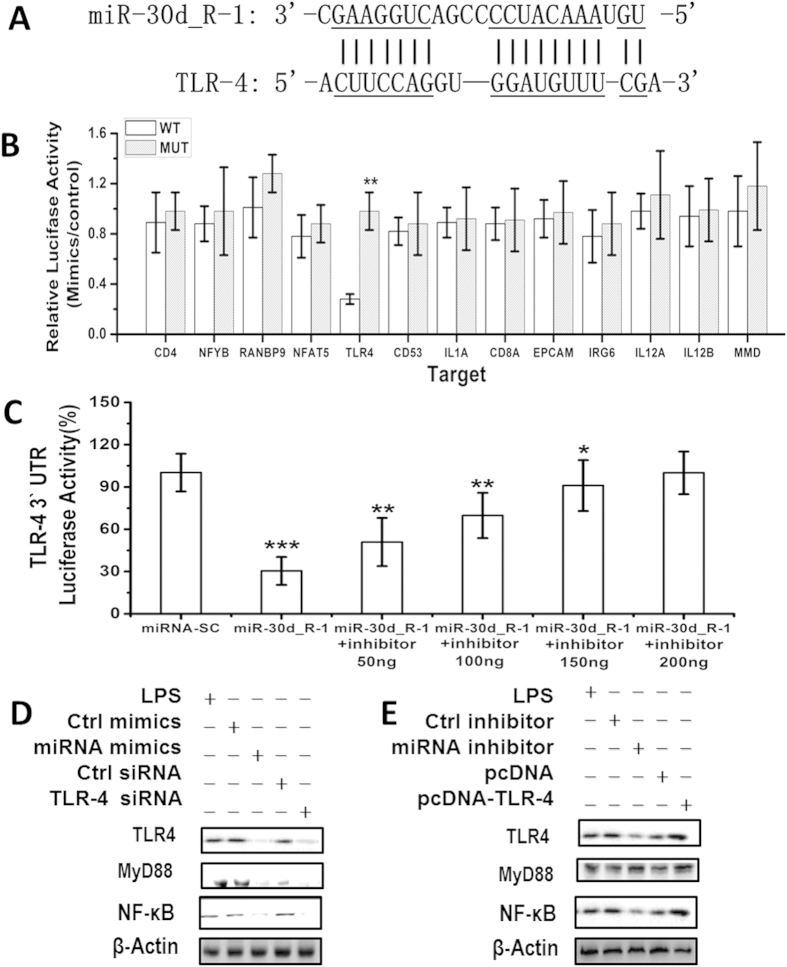
Direct targeting of TLR4 mRNA by ssc-miR-30d_R-1.The predicted conserved ssc-miR-30d_R-1-binding site (underlined) in the 3′-UTR of pig TLR4 mRNA (A). Luciferase activity in MARC-145 cell lysates transfected with constructs encoding wild-type (WT) or mutated (Mut) target gene 3′-UTRs plus mimics (B) or inhibitors (C) of ssc-miR-30d_R-1 (or the appropriate control). Validation of ssc-miR-30d_R-1 targeting of the TLR4 3′-UTR by treatment with different doses of inhibitor at 48 h after transfection (D). *P < 0.05 and **P < 0.01 (Student’s t test). Data are from three independent experiments (mean ± SD). (E) MARC-145 cells transfected with ssc-miR-30d_R-1 (miRNA) mimic or inhibitor, control siRNA, pc-DNA-TLR4 or TLR4 siRNA plasmids were stimulated by LPS. Expression of β-actin (internal control), TLR4, MyD88, and NF-κB were detected by Western blot. Data shown are representative of three independent experiments.